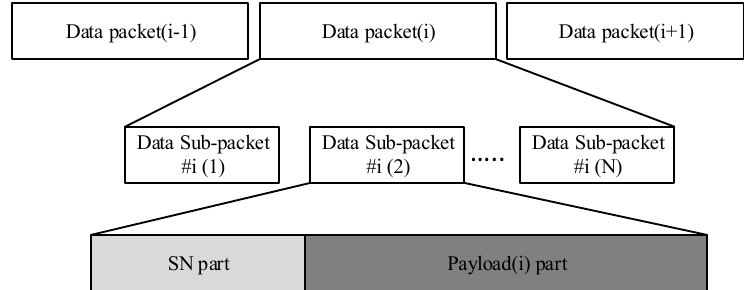
Figure 4. The proposed data frame structure for RS-OFDM system .